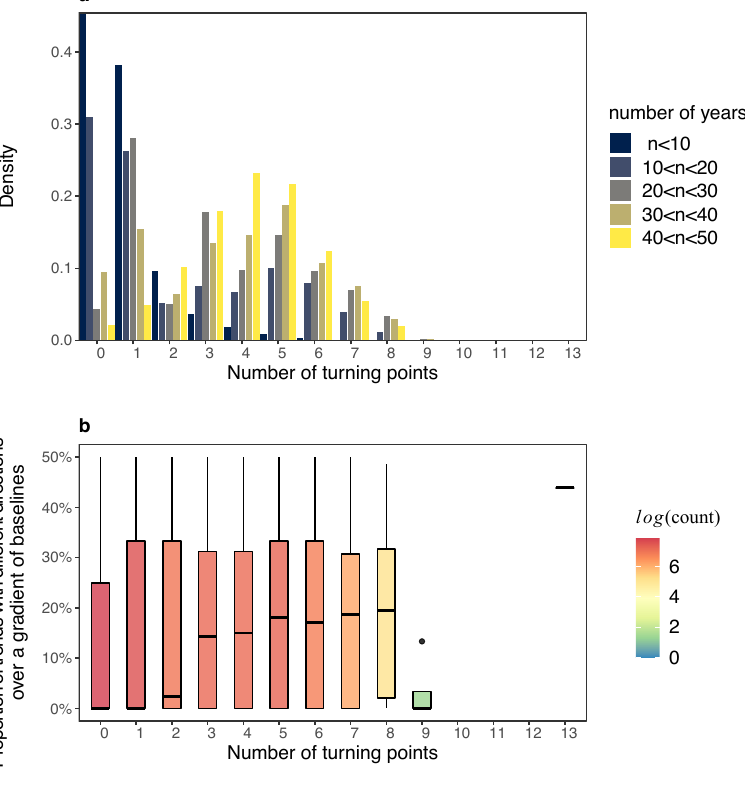
Figure 3: Empirical time series of arthropod abundance are non-monotonous, leading to unstable abundance trends over a gradient of baseline years. (a) Distribution of the number of original time series as a function of the number of turning points (a proxy for non-monotony, cf. Methods) and of the number of years with data in the corresponding time series. (b) Variation in direction of abundance trends (positive vs. negative) of truncated time series, as a function of the number of years with data in the corresponding time series. Truncated time series are from the same original time series which is truncated for every possible baseline year (cf. Methods, Fig. 2). Boxplots represent minimum and maximum values (bottom and top of vertical lines), first and third quartiles (Q1 and Q3, bottom and top of boxes) and median (thick horizontal lines); colours indicate sample size (number of original time series). Points with values outside of the range [Q1-1.5(Q3-Q1), Q3+1.5(Q3-Q1)] are considered as outliers and represented as full